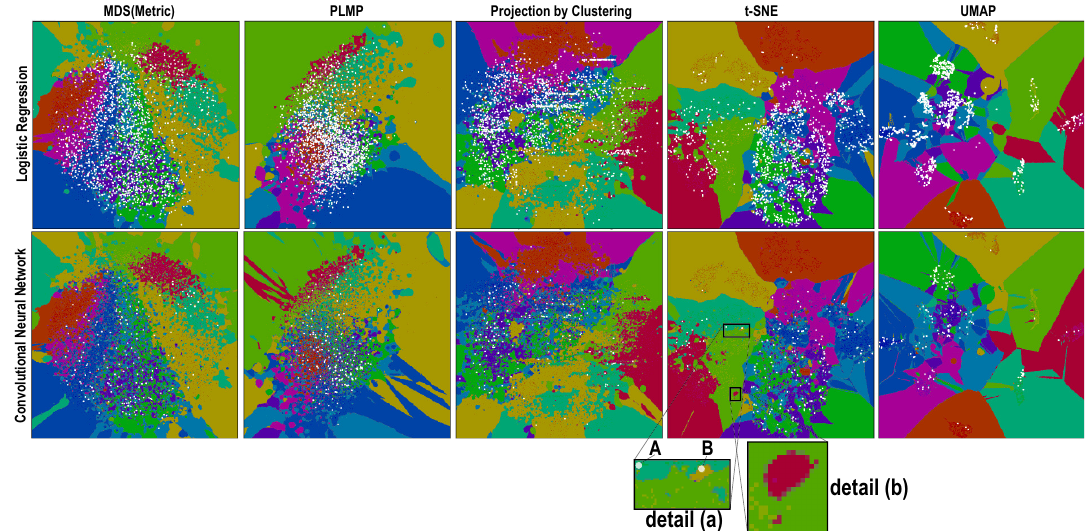
Figure 5. Classification errors (white dots) shown atop of the dense maps, logistic regression (LR) and CNN